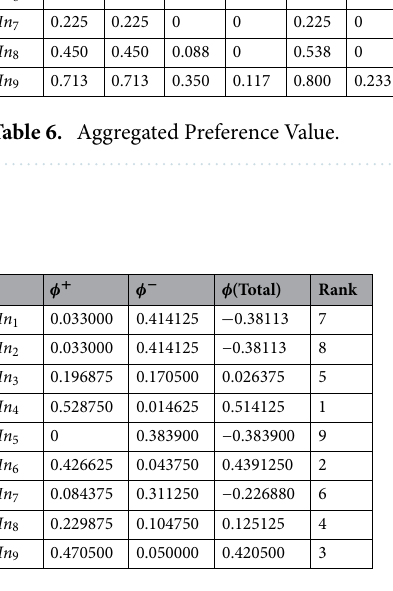
Table 7. Positive, Negative Ranking Flow, and Net Outranking